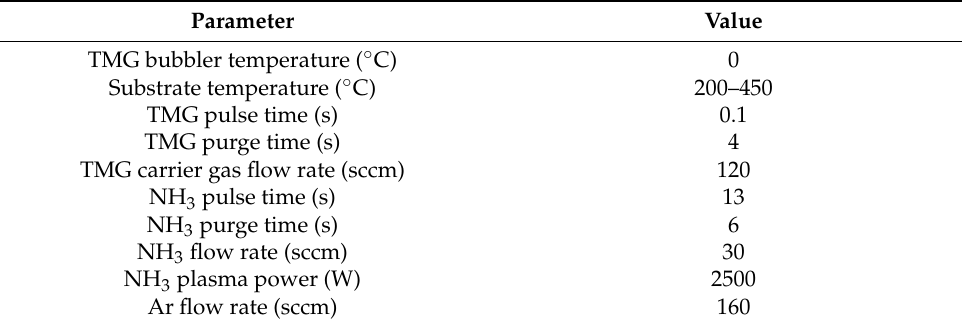
Table 1. Deposition parameters for PEALD GaN thin